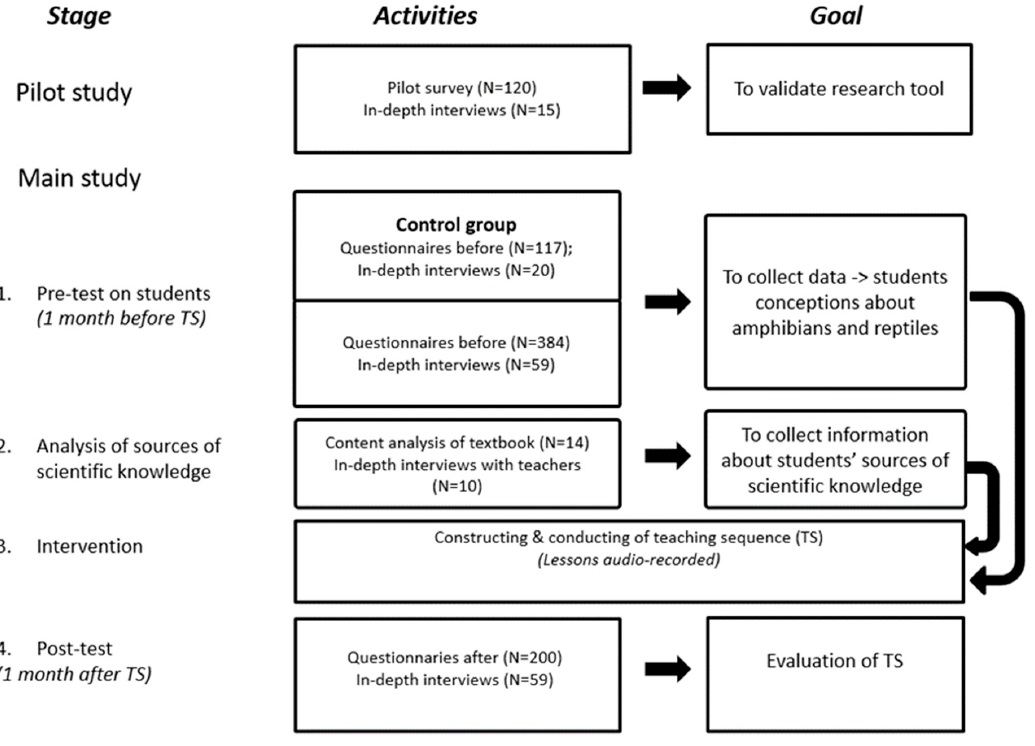
Figure 1. Outline of the conducted project.